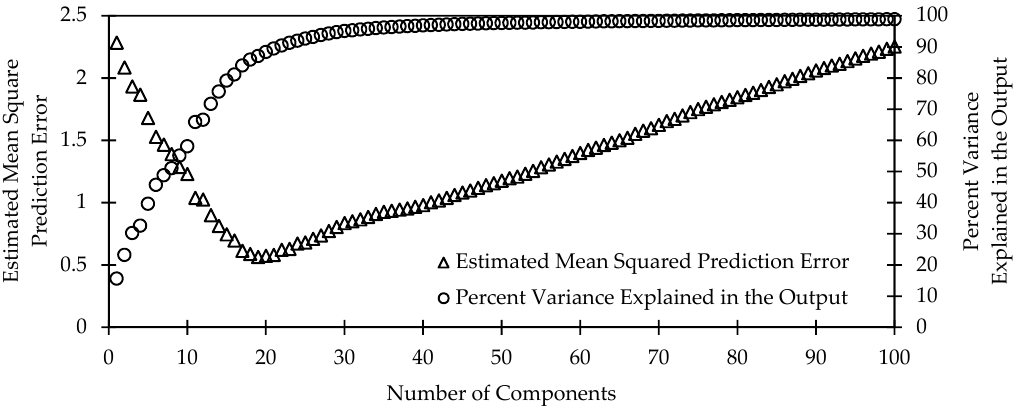
Figure 8. Estimated mean square prediction error and the variance explained in the output versus number of components in a model.